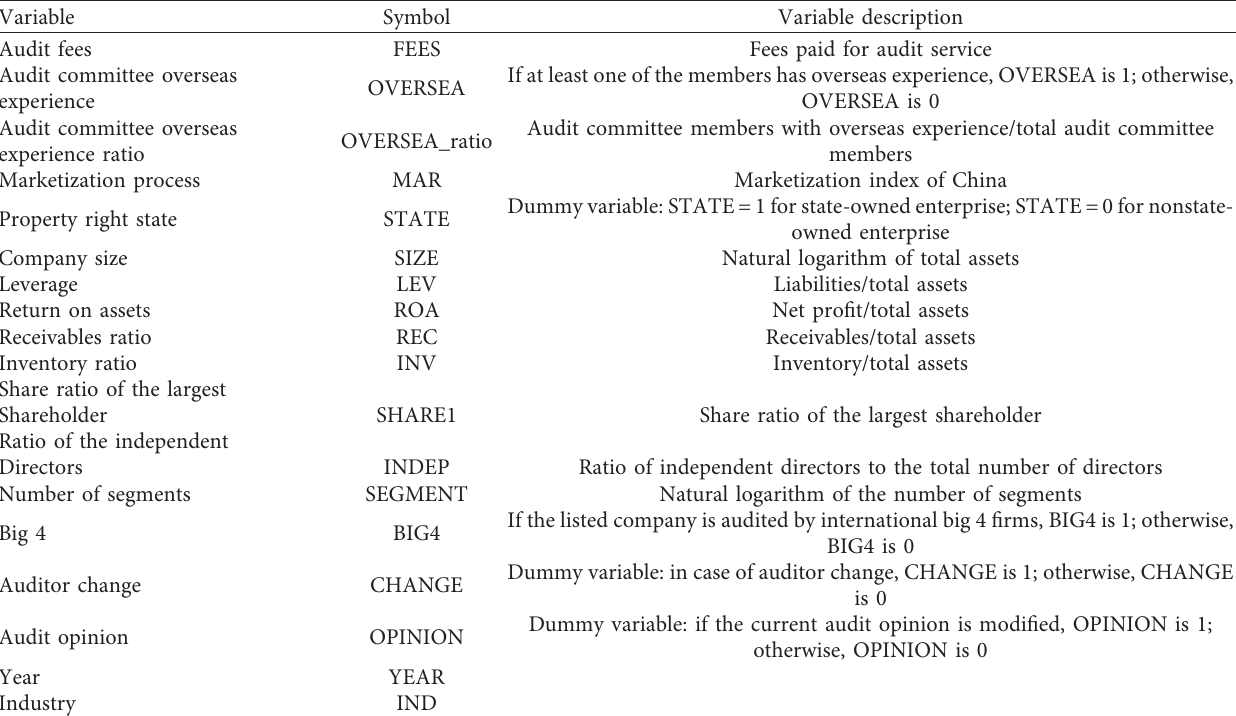
Table 1: Main definitions of